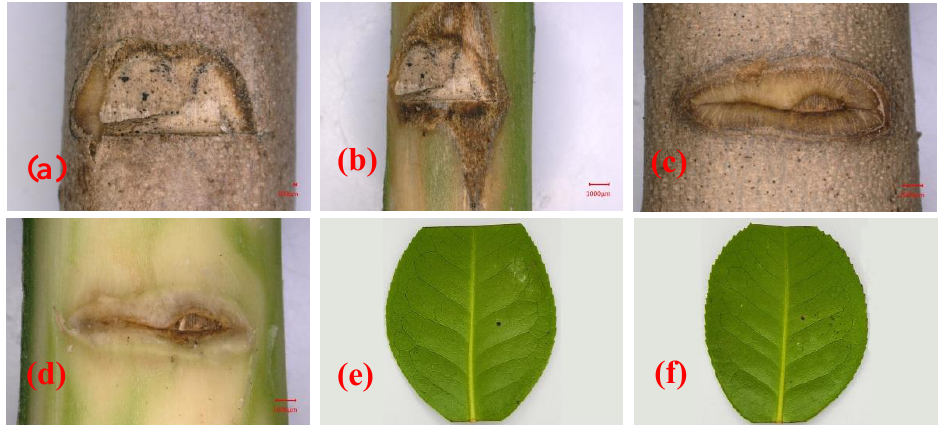
Figure 4. Pathogenicity analysis of Nectria pseudotrichia on the stems and detached leaves of Camellia japonica ‘ Hongluzhen ’ . ( a , b ) Lesions on and beneath the bark of a camellia stem inoculated with N. pseudotrichia , respectively; ( c , d ) lesions on and beneath the bark of a camellia stem inoculated with a sterile PDA plug, respectively; ( e , f ) lesions on detached leaves inoculated with sterile PDA and N. pseudotrichia, respectively.